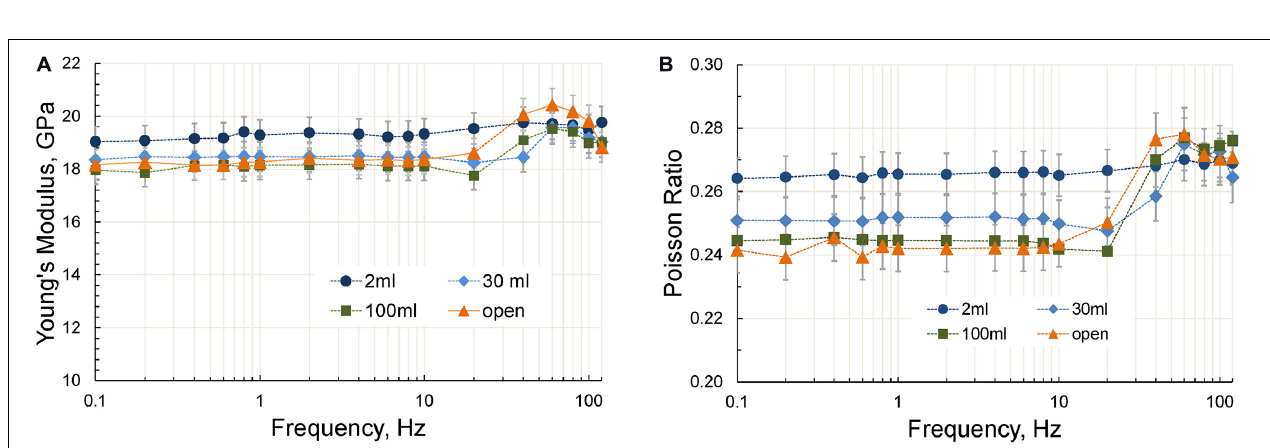
FIGURE 9 | The dependencies of the extensional attenuation (A) and P-wave and S-wave velocities (B) on time. The measurements are carried out at a uniaxial pressure of 10 MPa.